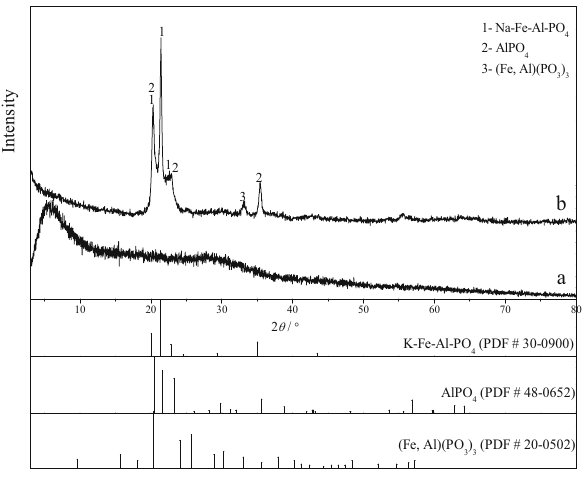
Figure 7: XRD patterns of iron aluminum - containing phosphates generated during the iron and aluminum separation under opti - mized conditions. ( a ) Uncalcined sample ( HWWS - FP ) ; ( b ) calcined sample ( HWWS - FPC )